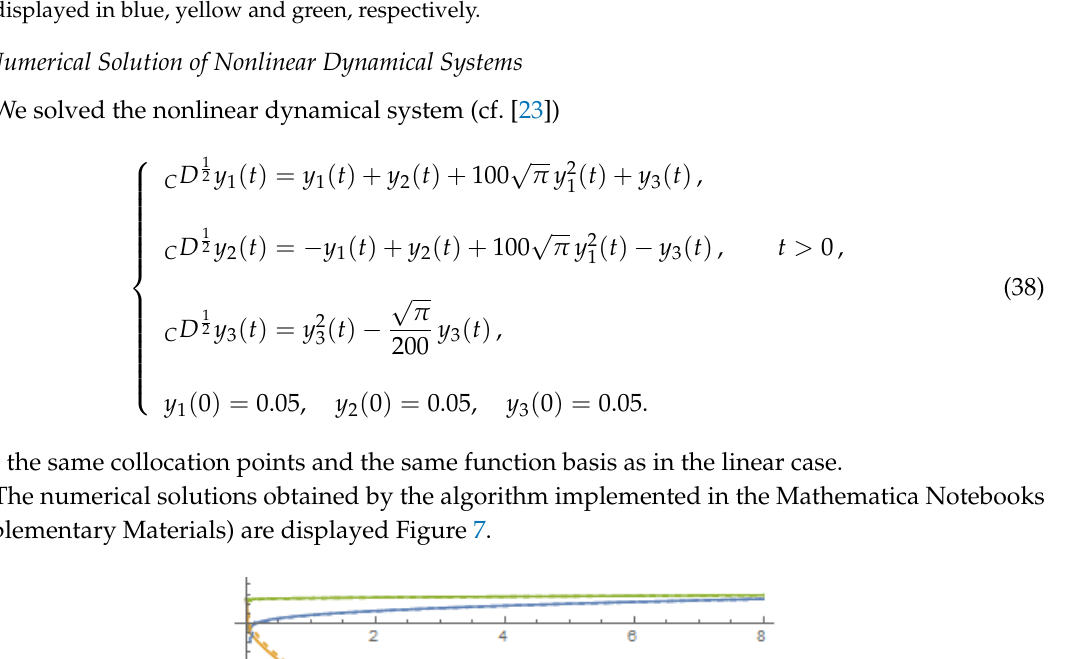
Figure 6. The numerical solution Y nh ( t ) for n = 3 (solid lines) and n = 1 (dashed line) of the linear dynamical system (37). In both cases h = 1 . The first, second and third entries of the vector Y nh ( t ) are 16 displayed in blue, yellow and green, respectively.